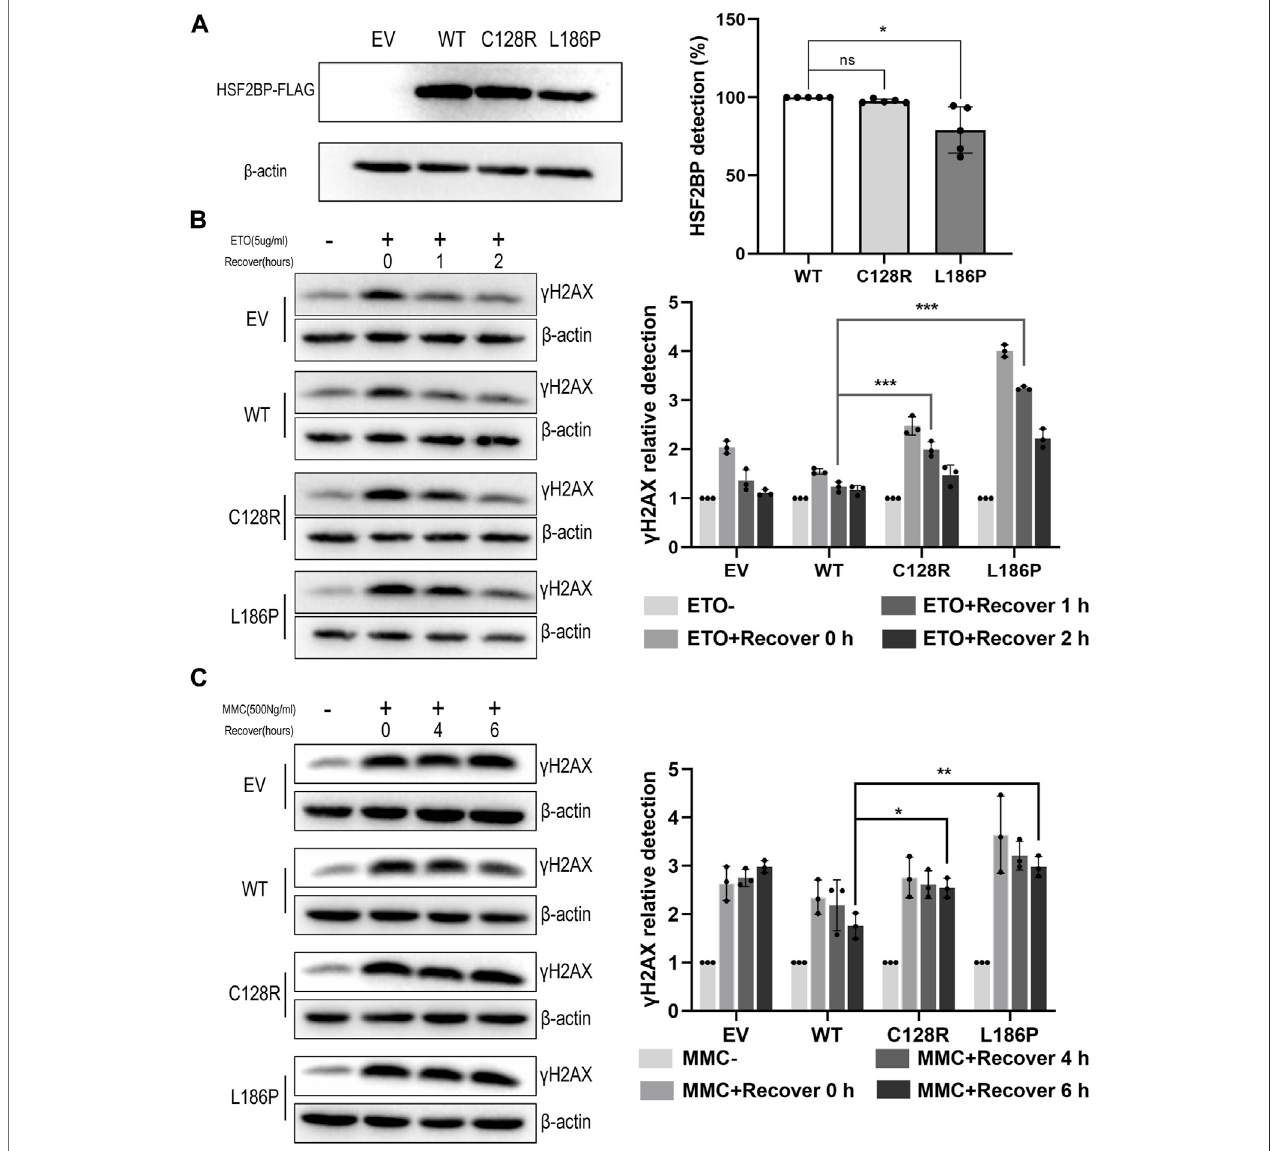
FIGURE 4 | The variation C128R and L186P impaired the DNA repair capacity of HSF2BP. (A) The expression level of wild-type (WT) and mutant HSF2BP-FLAG (C128R and L186P) were tested by Western blotting. β -Actin was used as the loading control. Graph on the right represents the relative quanti fi cation of the immunoblotting.* p < 0.05. (B,C) The γ H2AXlevelwasdetectedbyWesternblottinginHeLacellsoverexpressingemptyvector(EV),wild-type(WT),ormutantHSF2BP- FLAG (C128R and L186P) with or without etoposide (ETO) (B) or mitomycin (MMC) (C) treatment. The relative grayscale scores of γ H2AX in the cells overexpressing mutant HSF2BP (C128R and L186P) were compared with those overexpressing wild-type (WT) HSF2BP at speci fi c recovery time points after ETO or MMC treatment (the grayscale of no treatment was considered as one in each group). β -Actin was used as the loading control. * p < 0.05, ** p < 0.01, *** p < 0.001.